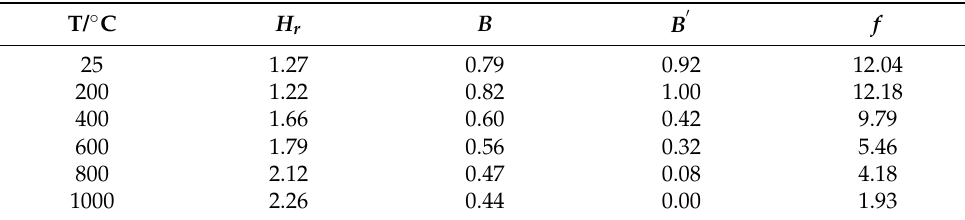
Table 3. Brittleness index and Proctor coefficient of rock at different temperatures.